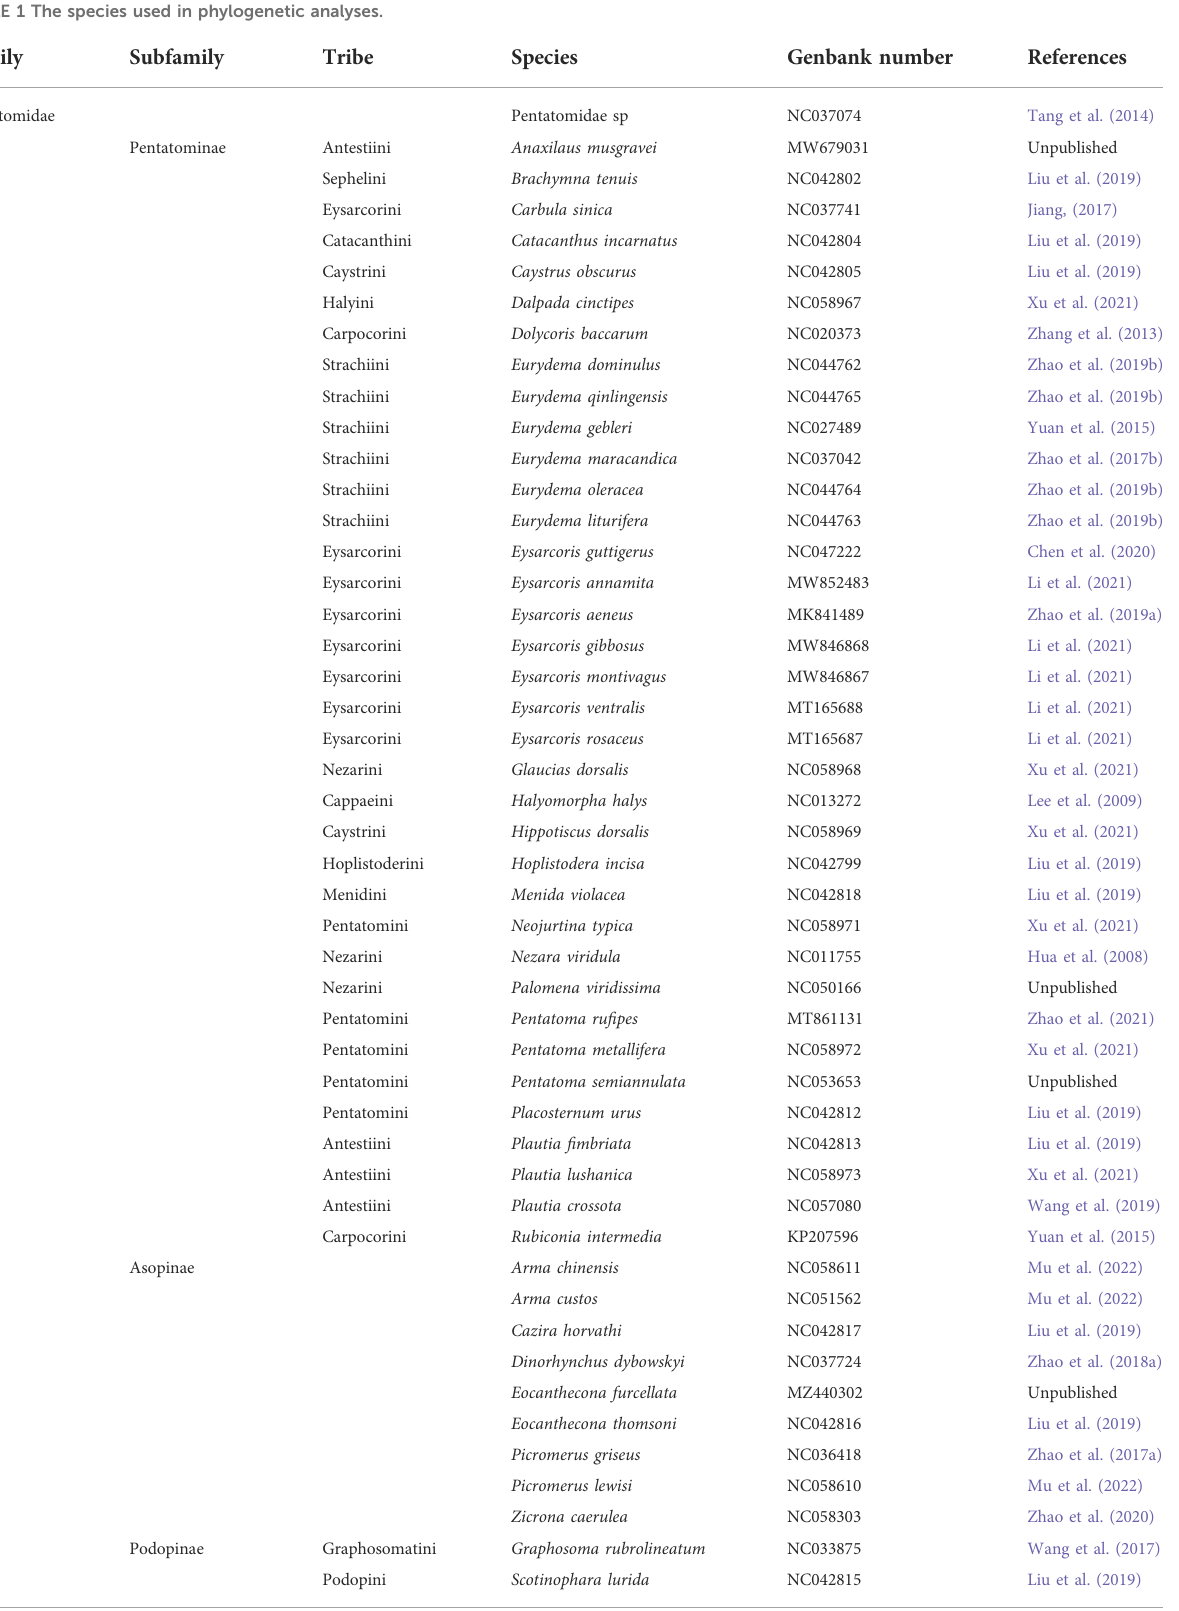
TABLE 1 The species used in phylogenetic